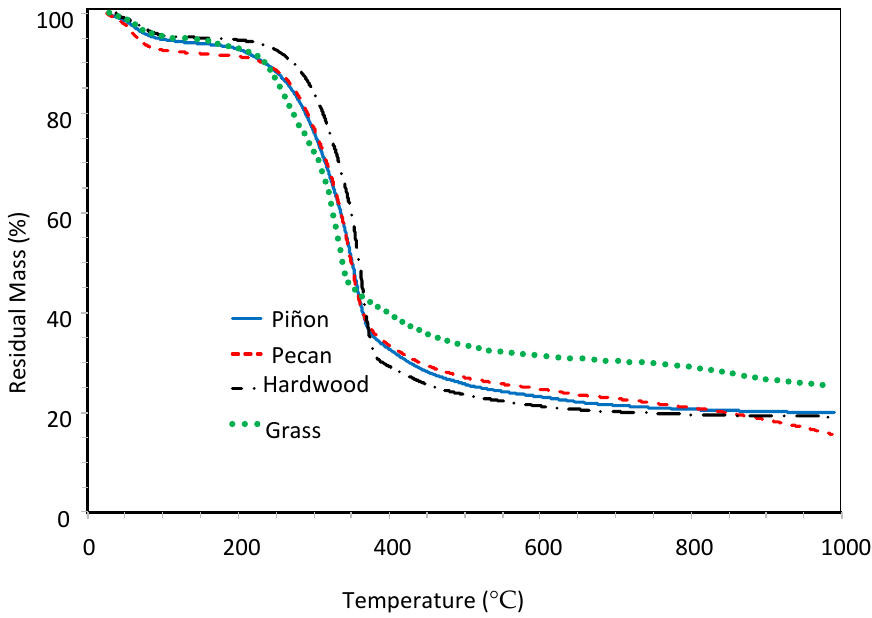
Figure 4. TGA of biomass samples pyrolyzed under nitrogen. The heating rate was 10 °C min −1 .